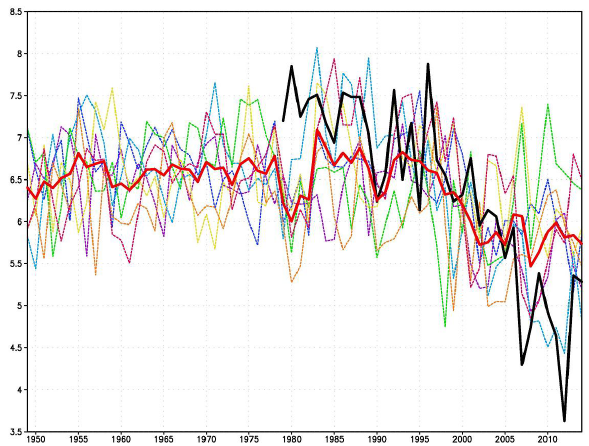
Figure 7. September Arctic sea ice extent (10 12 m 2 ) for observa- tions (Comiso and Nishio, 2008) (thick solid black); model mean (thick solid red). Dashed thin lines represent data from individual model runs. Colors correspond to individual runs as in Fig. 1.